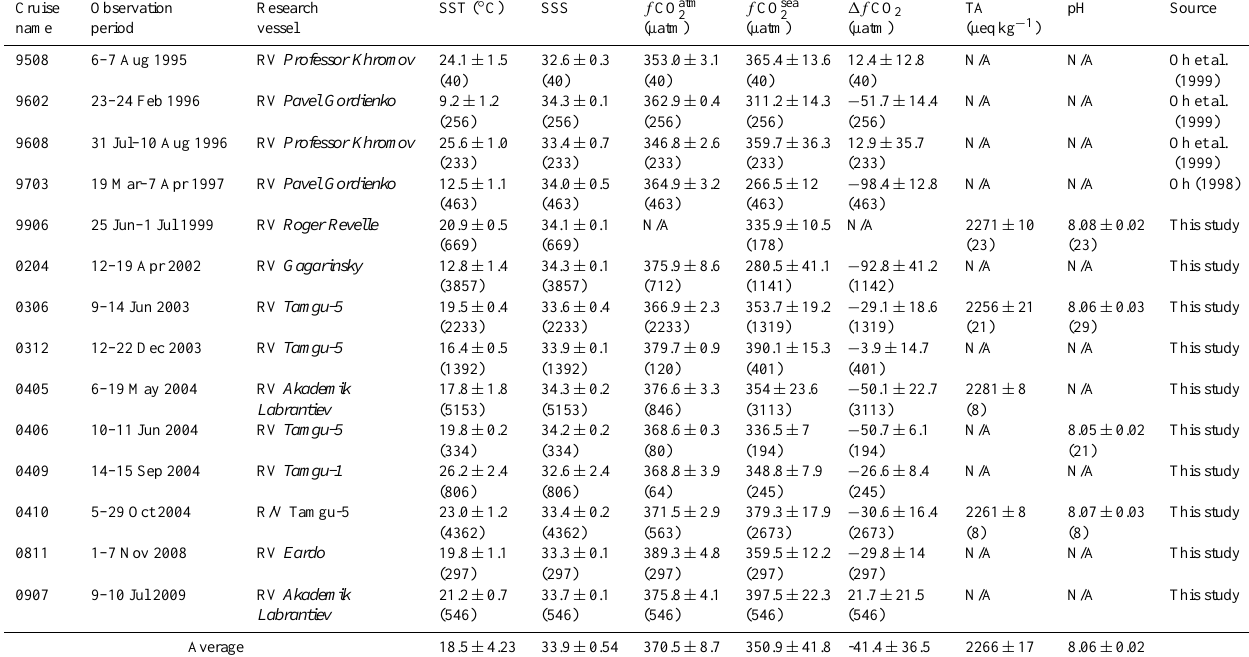
Table 1. Information for cruises in this study: SST, SSS, f CO atm and standard deviations. The average values are arithmetic mean of 1 or 2min averaged values in the cruise. The number of data values IS listed in